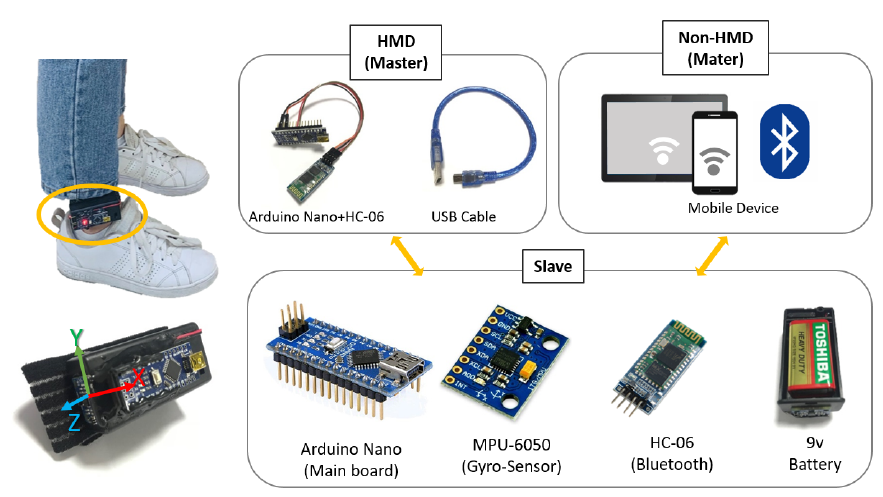
Figure 3. Structure of a walking simulator [8] for HMD and non-HMD users.